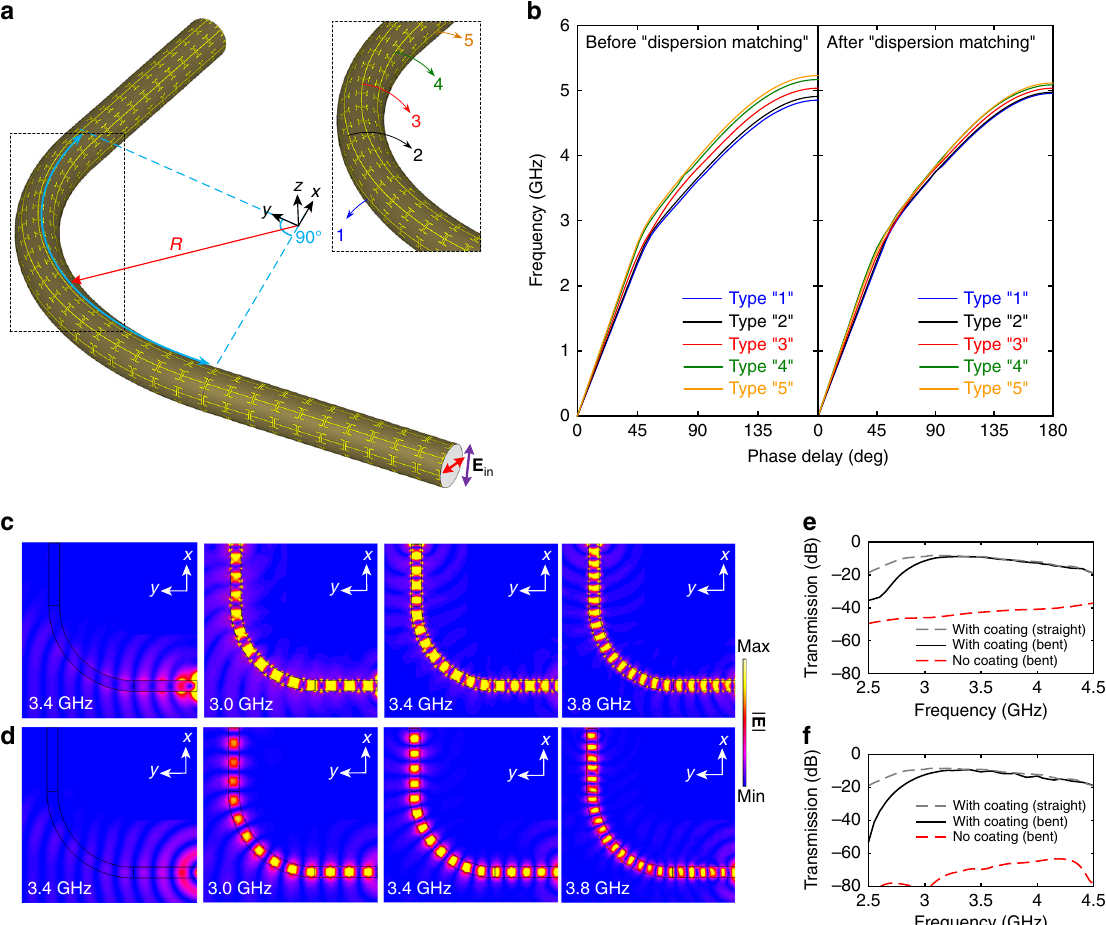
Fig. 6 A right-angle dielectric rod waveguide bend with a single-layer metasurface coating. a Con fi guration of the right-angle Te fl on rod waveguide bend coated by the metasurface guiding layer with an inhomogeneous distribution of unit cells in the bending section. The inset shows the enlarged view of the bending section, with the 5 types of unit cells labeled out. b Simulated dispersion curves for the fi ve types of unit cells before and after “ dispersion matching ” . The dimensions for unit cells in progressive order from type “ 1 ” to type “ 5 ” are: p = 14, 14.3, 15, 15.7, 16 mm, q = 7.05, 6.75, 6.5, 6.2, 6 mm, and s = 0.35, 0.37, 0.5, 0.7, 0.75 mm. Snapshots of the electric fi eld distribution of a bare and the coated Te fl on rod waveguide bending in the c electric and d magnetic fi eld plane. The simulated transmission between the transmitting and receiving probes for the bare and coated Te fl on rod waveguide bending in the e electric and f magnetic fi eld plane, as well as for the straight coated Te fl on rod